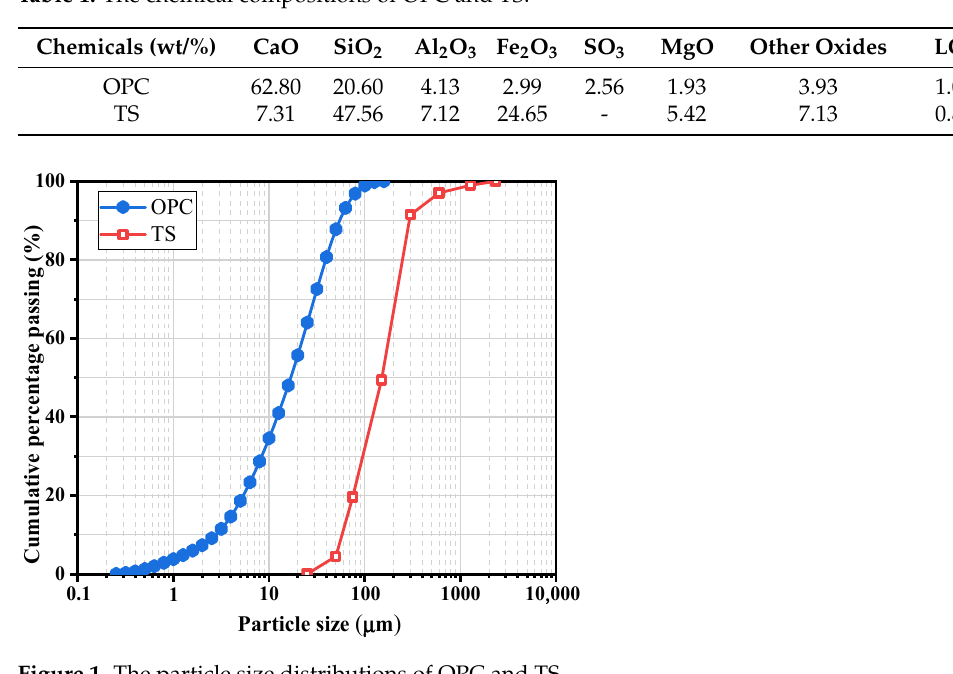
Figure 1. The particle size distributions of OPC and TS.